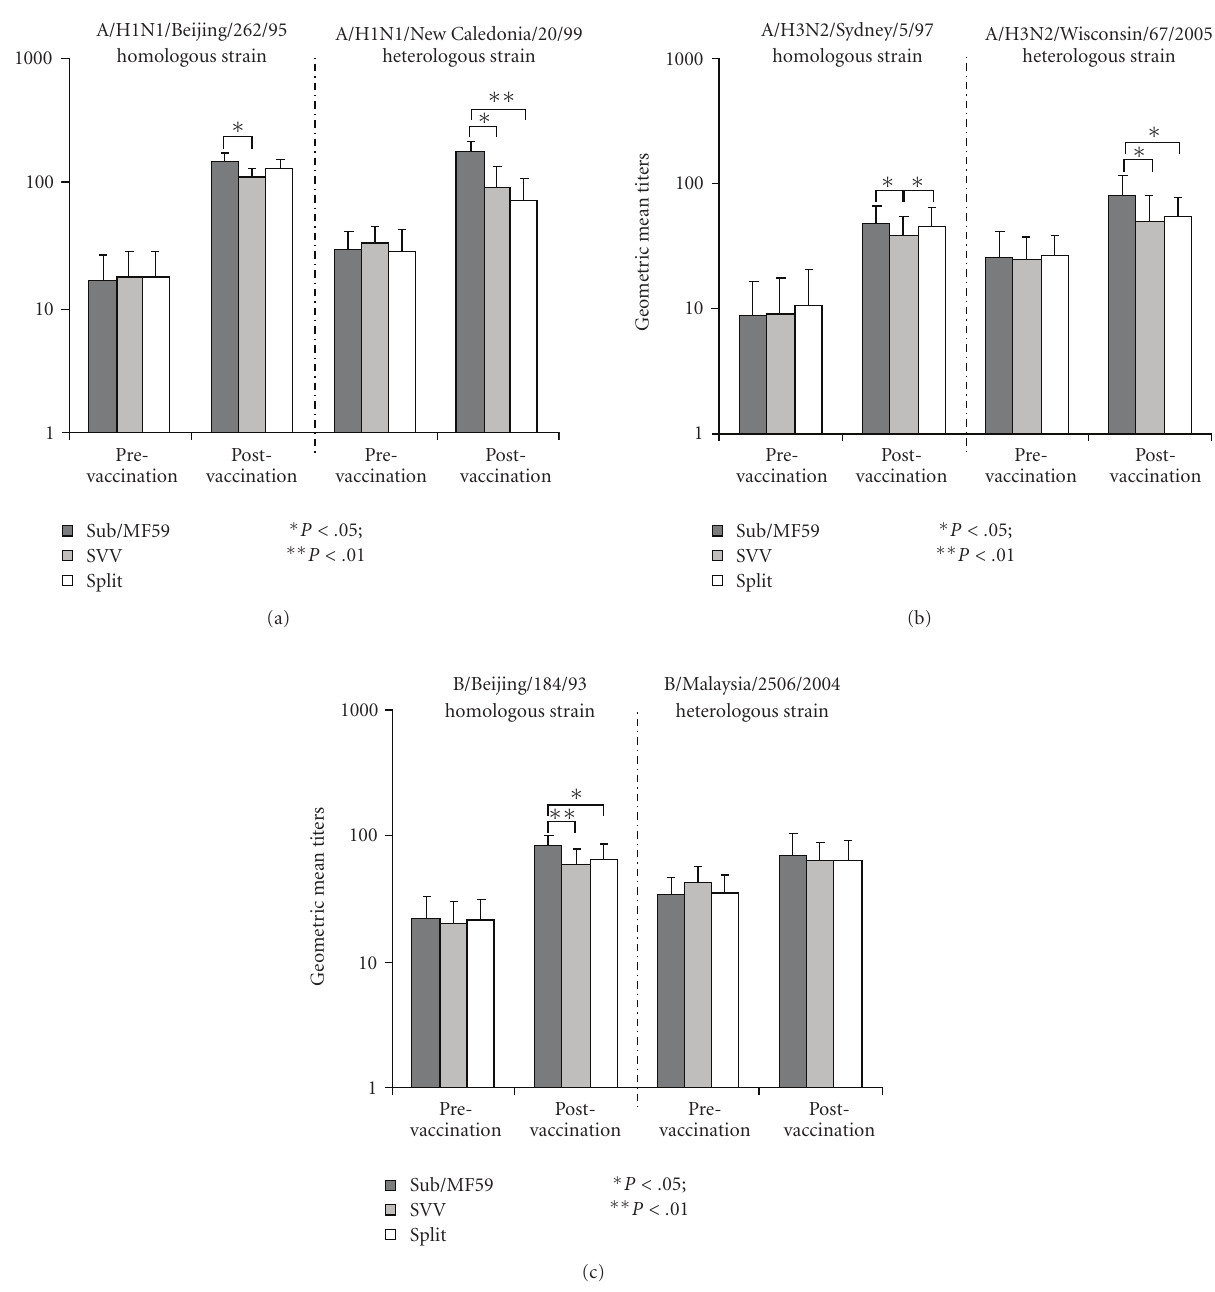
that bear no close antigenic similarity to those included in the vaccine formulation. For both heterologous A influenza strains, Sub/MF59 induced significantly higher HI antibodies and 4-fold increases in titers than the two non-adjuvanted comparators. For the B drifted strain, significantly higher HI titers were induced by MF59 adjuvanted vaccine, compared with SVV, and both adjuvanted and conventional split vaccine showed the highest increases in titers, compared with the virosomal